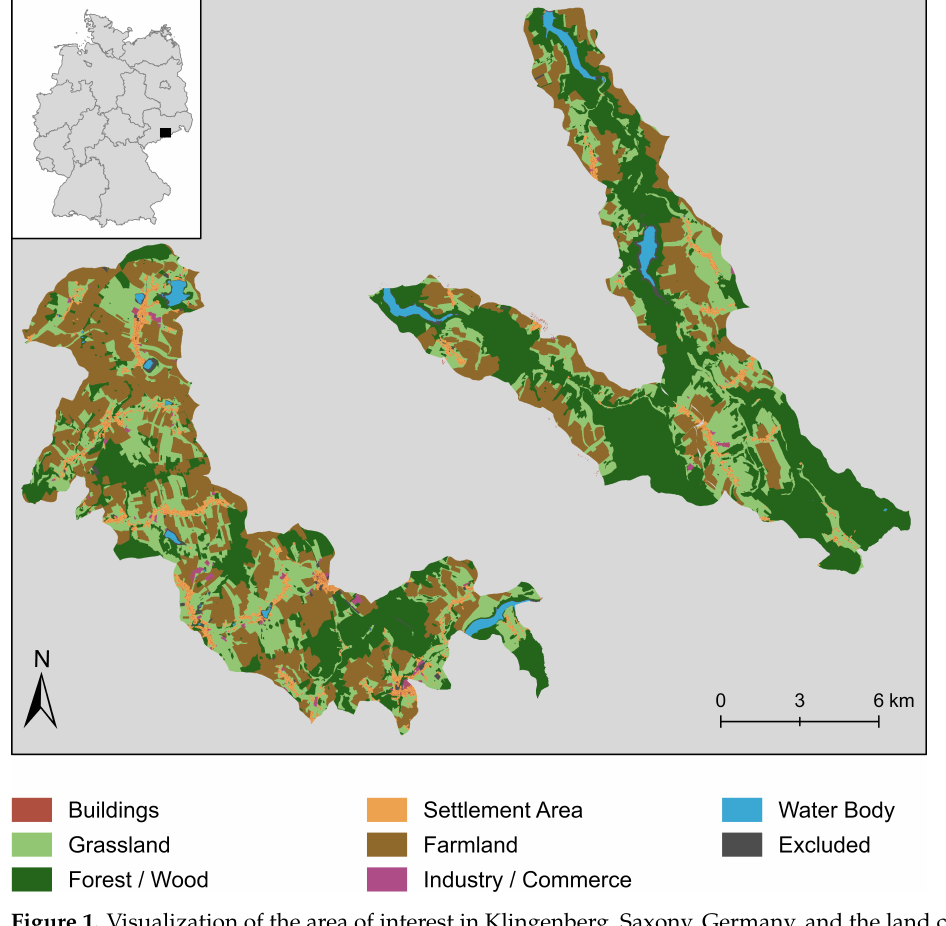
Figure 1. Visualization of the area of interest in Klingenberg, Saxony, Germany, and the land cover ground truth (GT)